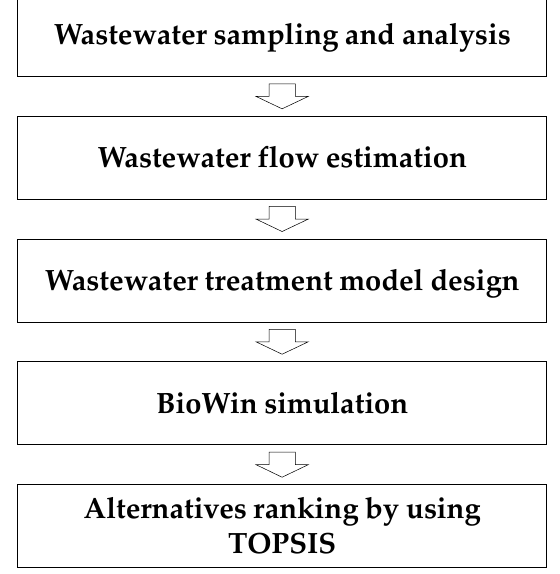
Figure 3. Analysis flowchart for the optimized design of a wastewater treatment system in Vientiane, Laos. TOPSIS: technique for order preference by similarity to ideal solution.